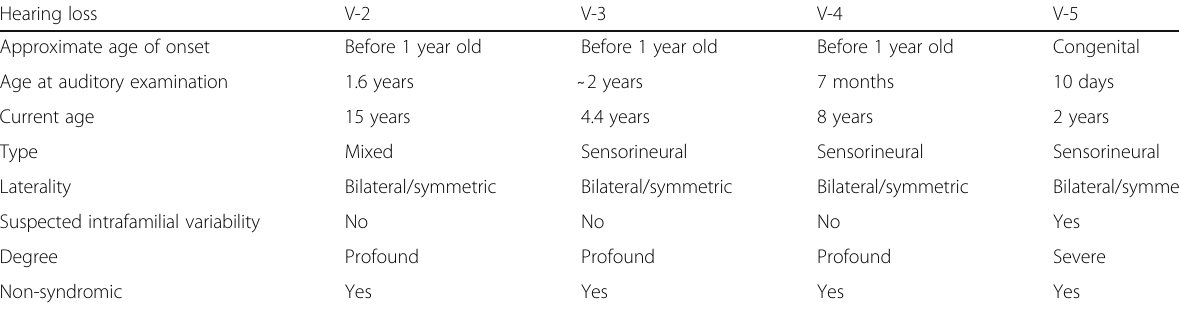
Table 1 Characterization of HL in each affected individual in family E30